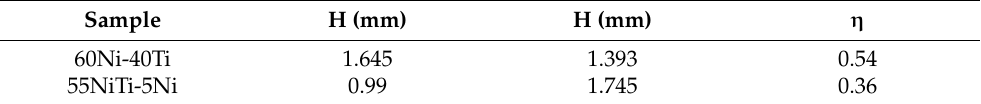
Figure 3. Optical microscopy (OM) images of coatings: ( a ) 60Ni-40Ti; ( b ) 55NiTi-5Ni. Table 2. Dilution rates of coatings.